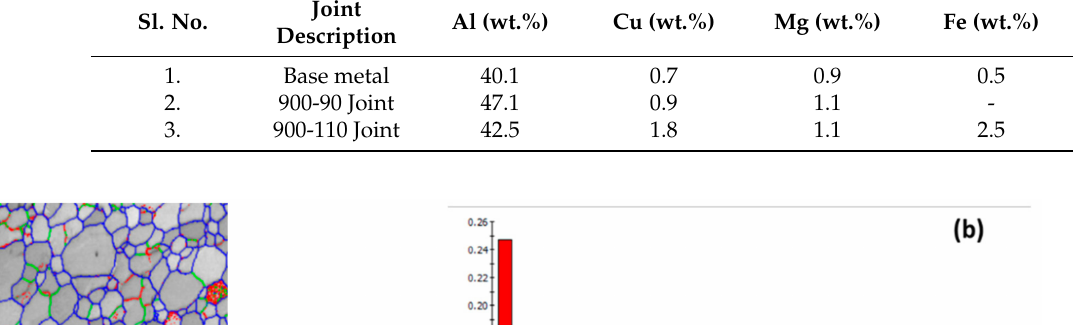
Table 5. Chemical elements present in the base-metal and in the weld joint. Sl. No.